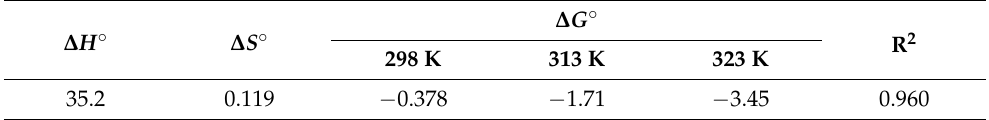
Table 4. Adsorption thermodynamic for vanadate removal from Mg-Fe-Ti-CLDH.